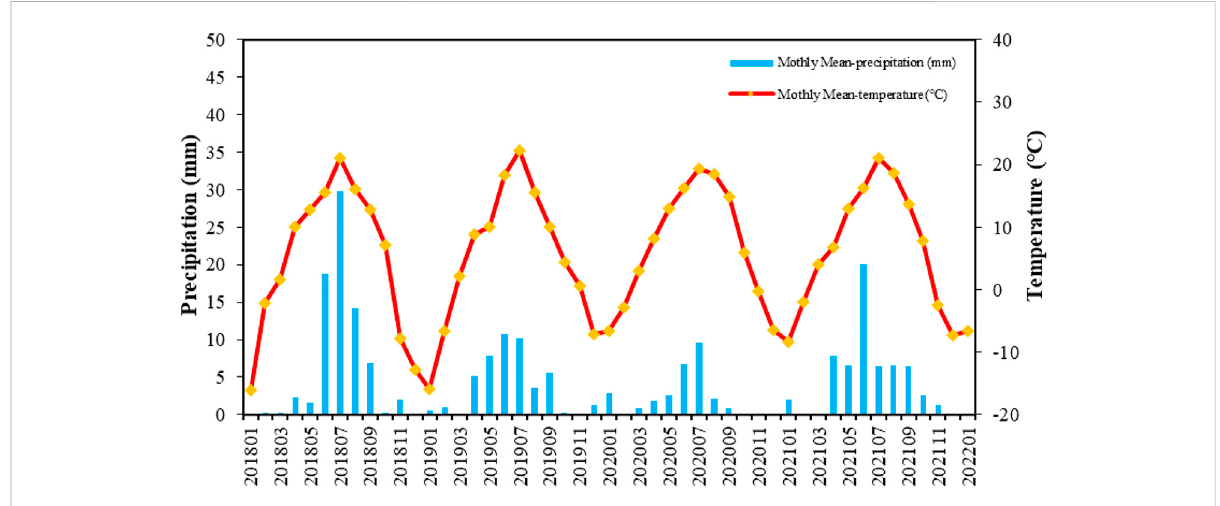
FIGURE 2 Monthly mean temperature and precipitation data of the Golmud station (36.417 ° N and 94.9 ° E) from January 2018 to January 2022.